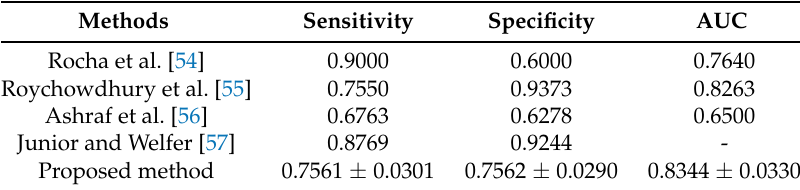
Table 10. Comparison of dark-lesion detection methods for the 45 retinal images with microaneurysms or hemorrhages of DIARETDB1